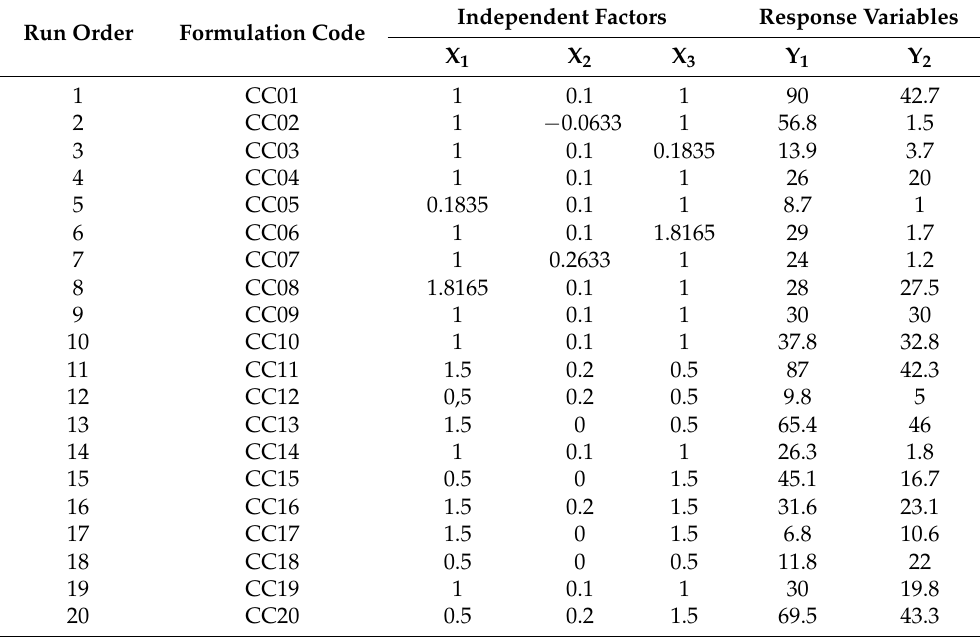
Table 4. Observed response for the 20 experimental runs in central composite design. Run Order Formulation